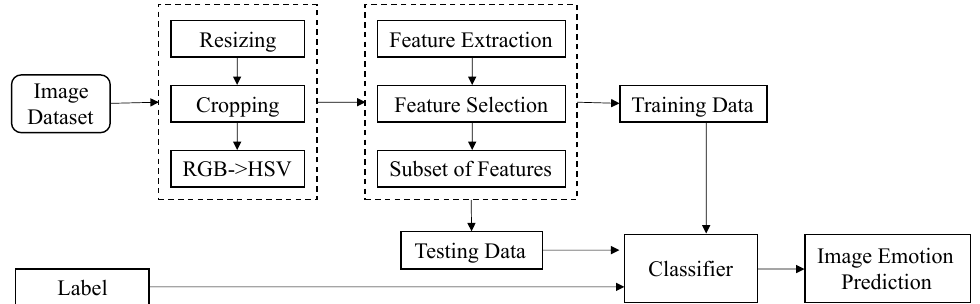
Figure 3. Flow chart of image sentiment classification. The PCNN uses the feedback mechanism to filter out the incorrectly labeled data in the training set, which further improves the ability of image sentiment classification. These eight types of emotions are amusement, anger, awe, contentment, disgust, excitement, fear,